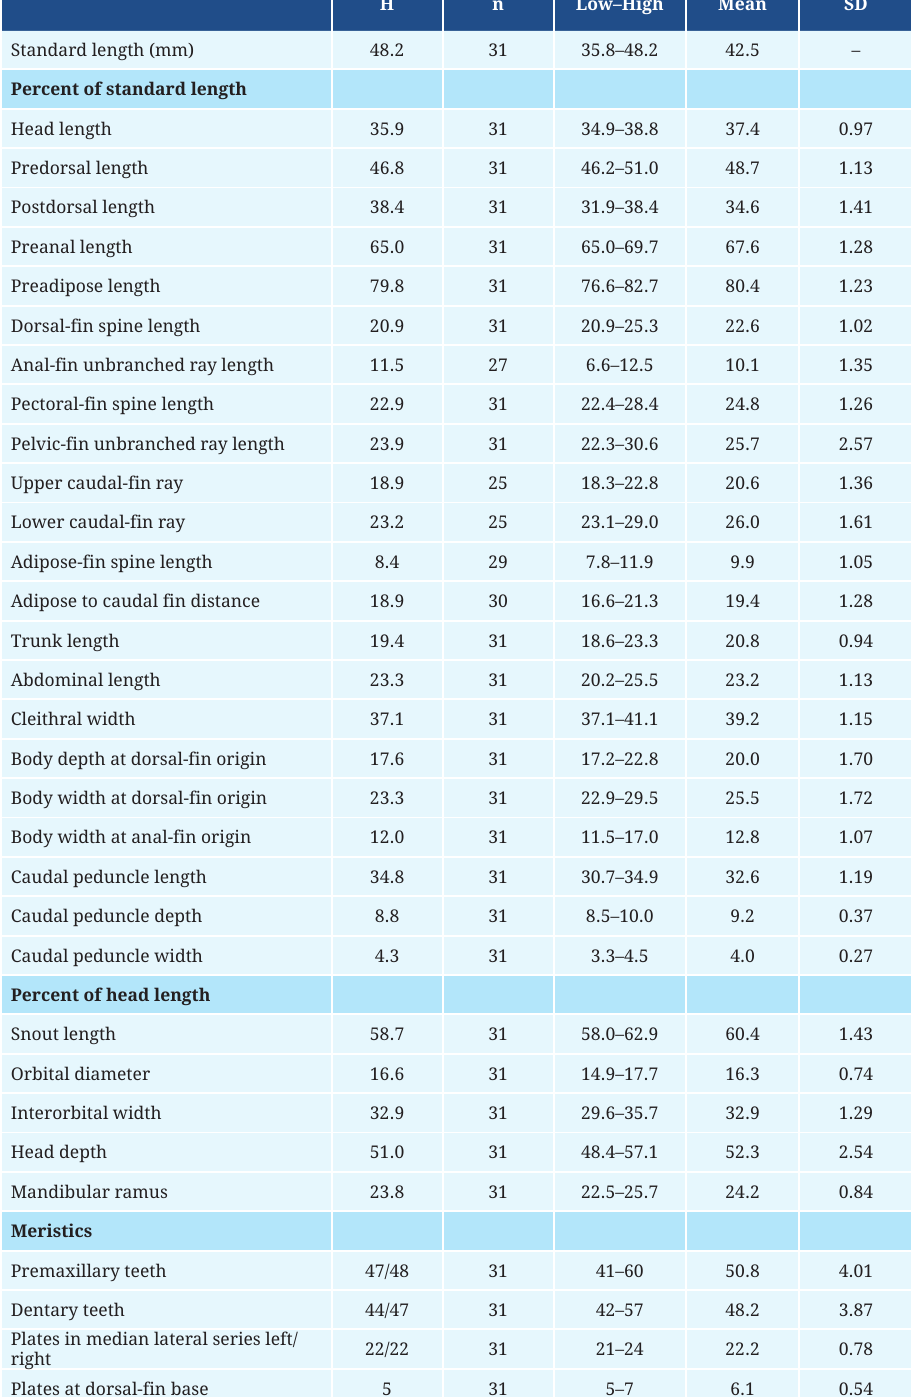
TABLE 1 | Morphometric and meristic data of Pareiorhaphis pumila . Values are given as percent